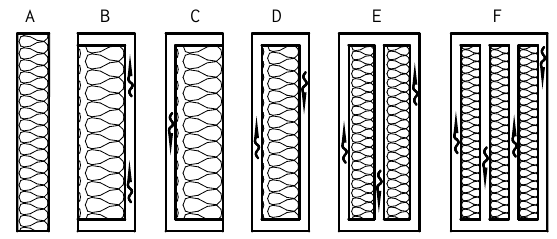
Fig. 4. The places showing the location of the air gap in constructions. The left side of the construction is warm, the right side is cold: A (cid:1) thermal-insulation without air gaps; B (cid:1) small air gap in the cold side of thermal-insulation; C (cid:1) separate small airgap on the warm side of thermal-insulation; D (cid:1) connecting small air gaps on the warm and cold sides; E (cid:1) two layers of slabs and three small air gaps; F (cid:1) three layers of slabs and four small air gaps